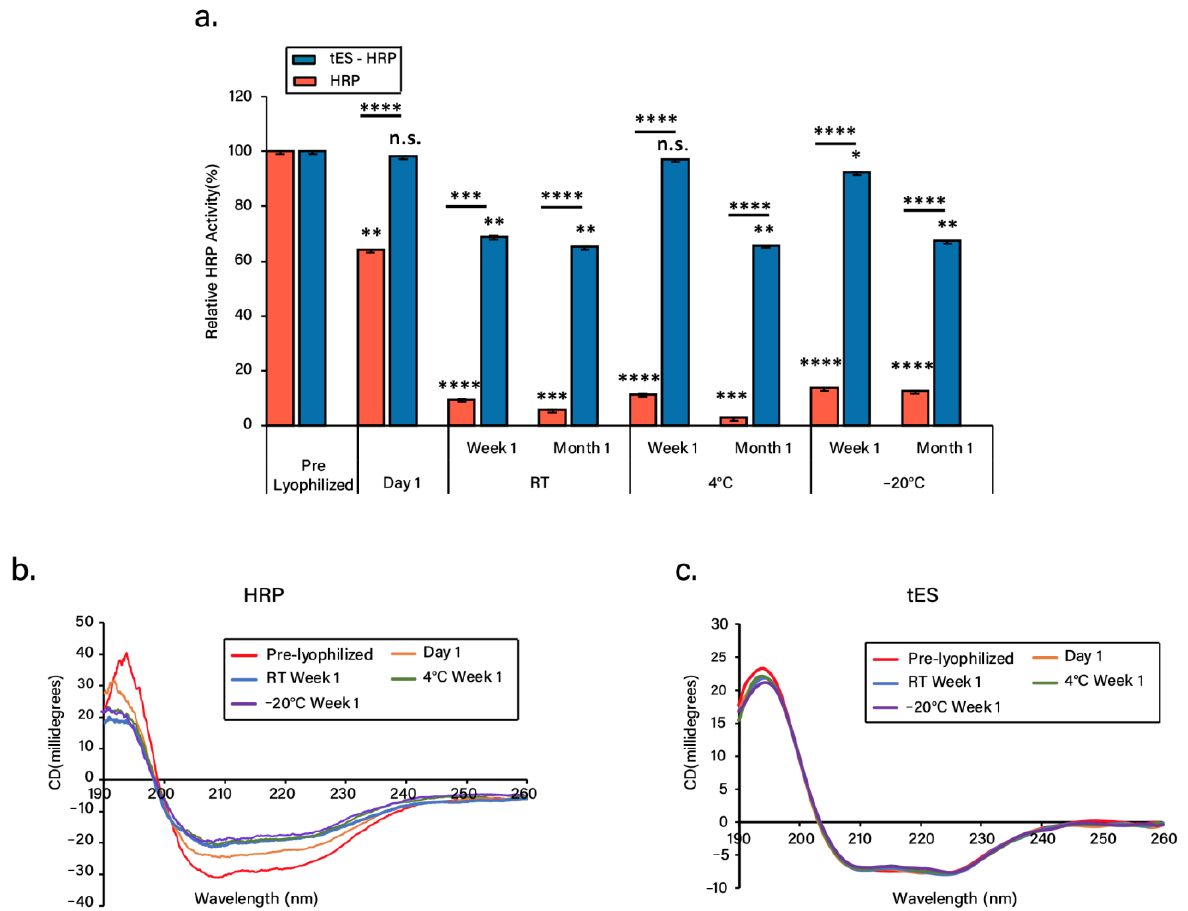
Figure 4. Functional and structural characterization of freeze-dried tES-HRP. ( a ) Enzyme activities of freeze-dried free or encapsulated HRP at different storage conditions: room temperature (RT), 4 ◦ C, and − 20 ◦ C for day 1, week 1, and month 1. The enzyme activities were compared to pre-lyophilized samples (control). ( b ) CD spectra of freeze-dried HRP at different storage conditions in comparison to the pre-lyophilized sample (control). ( c ) CD spectra of freeze-dried tES at different storage conditions in comparison to the pre-lyophilized sample (control). (n = 3, mean ± SD). Statistical significance (* p ≤ 0.1, ** p ≤ 0.01, *** p ≤ 0.001, **** p ≤ 0.0001) was determined by one-way ANOVA.